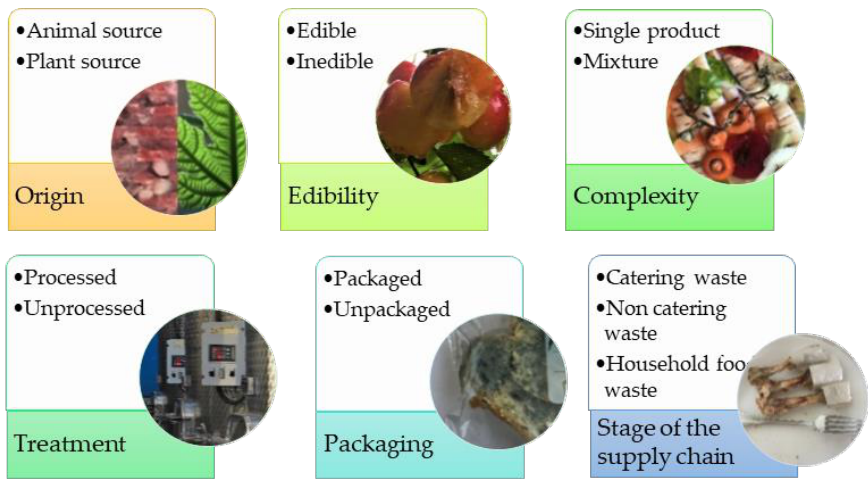
Figure 6. Classification of food waste (modified after [63]).